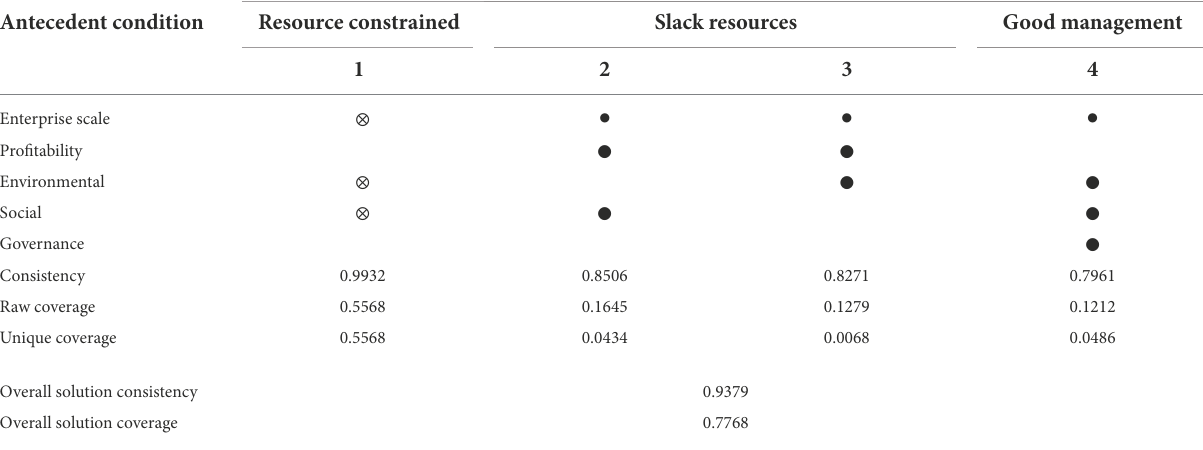
TABLE 4 Configurations strongly related to high firm